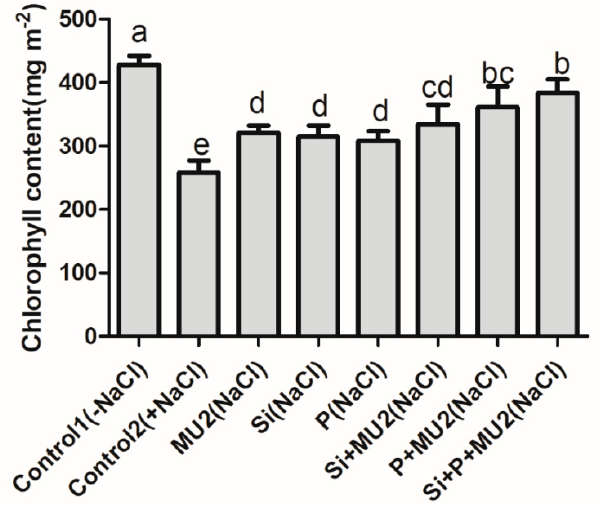
Figure 2. Effect of P. koreensis MU2 inoculation on the chlorophyll content of soybean plants grown under salt-stress conditions. Each data point represents the mean of at least six replicates. Error bars represent standard deviations. Bars with different letters are significantly different from each other at p ≤ 0.05.